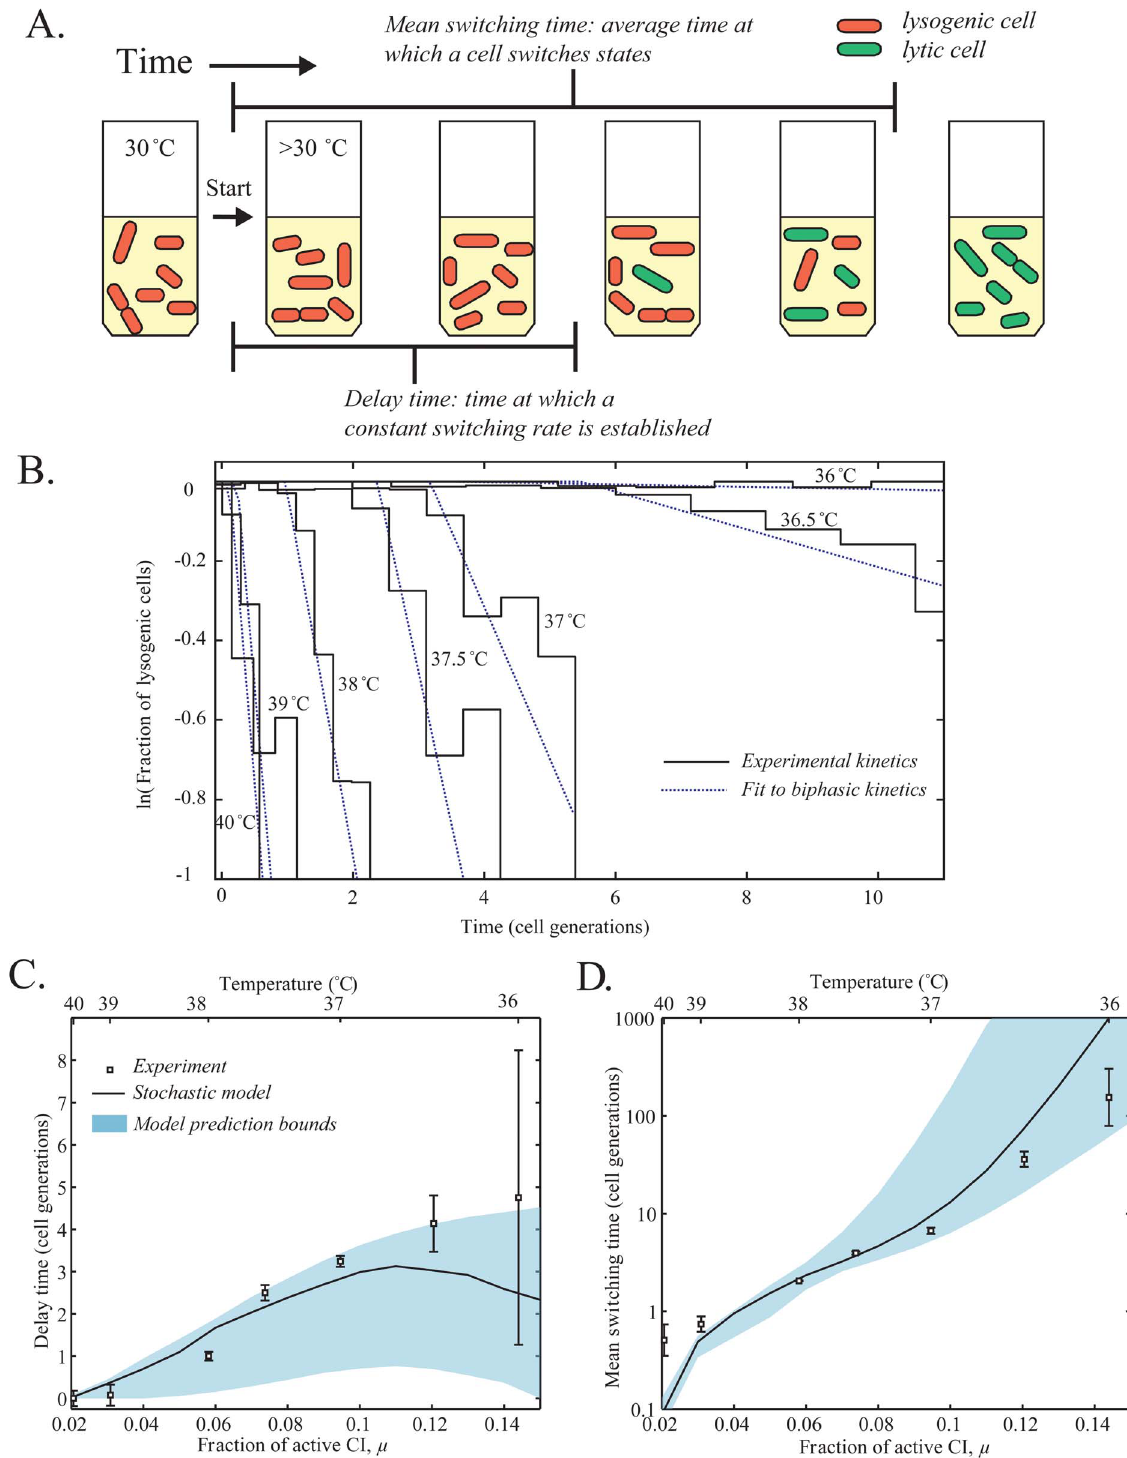
Figure 3. The kinetics of switching from lysogeny to lysis. ( A ) A schematic of the switching experiment. Cells were initially grown at 30 u C for , 5 generations, and then moved to a higher temperature. As a result, the population gradually switched from ‘‘red’’ (high CI, lysogenic) to ‘‘green’’ (high Cro, lytic). Two variables were extracted: The time when switching at a constant rate begins (designated the delay time) and the average time at which a cell switches from lysogeny to lysis (designated the mean switching time). ( B ) The fraction of remaining lysogens as a function of time, for different end temperatures in the range 36–40 u C. Each stair-step graph shows experimental data from a corresponding experiment. The dashed line is a fit to the observed biphasic behavior: delay followed by exponential switching. The fit was used to estimate the delay time and the mean switching time. ( C ) The delay time before switching as a function of the fraction of active CI, m (equivalently, temperature). Squares, experimental results and standard error from 3 independent experiments. Solid line and shaded region, results of the stochastic model and their estimated error. ( D ) The mean switching time as a function of the fraction of active CI, m (equivalently, temperature). Notation as in panel C . doi:10.1371/journal.pone.0100876.g003 PLOS ONE |